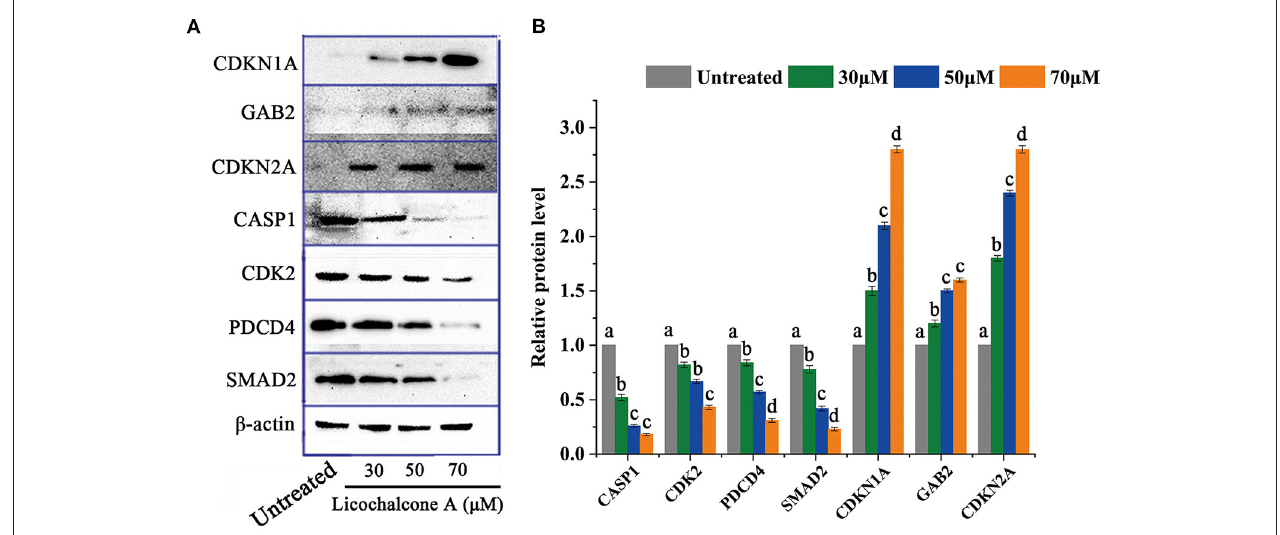
FIGURE 9 | The protein level of DEGs in critical signaling pathways. (A) Protein expression profile. (B) Expression levels of related proteins. Significant differences between the two groups were denoted by different letters ( p < 0.05).